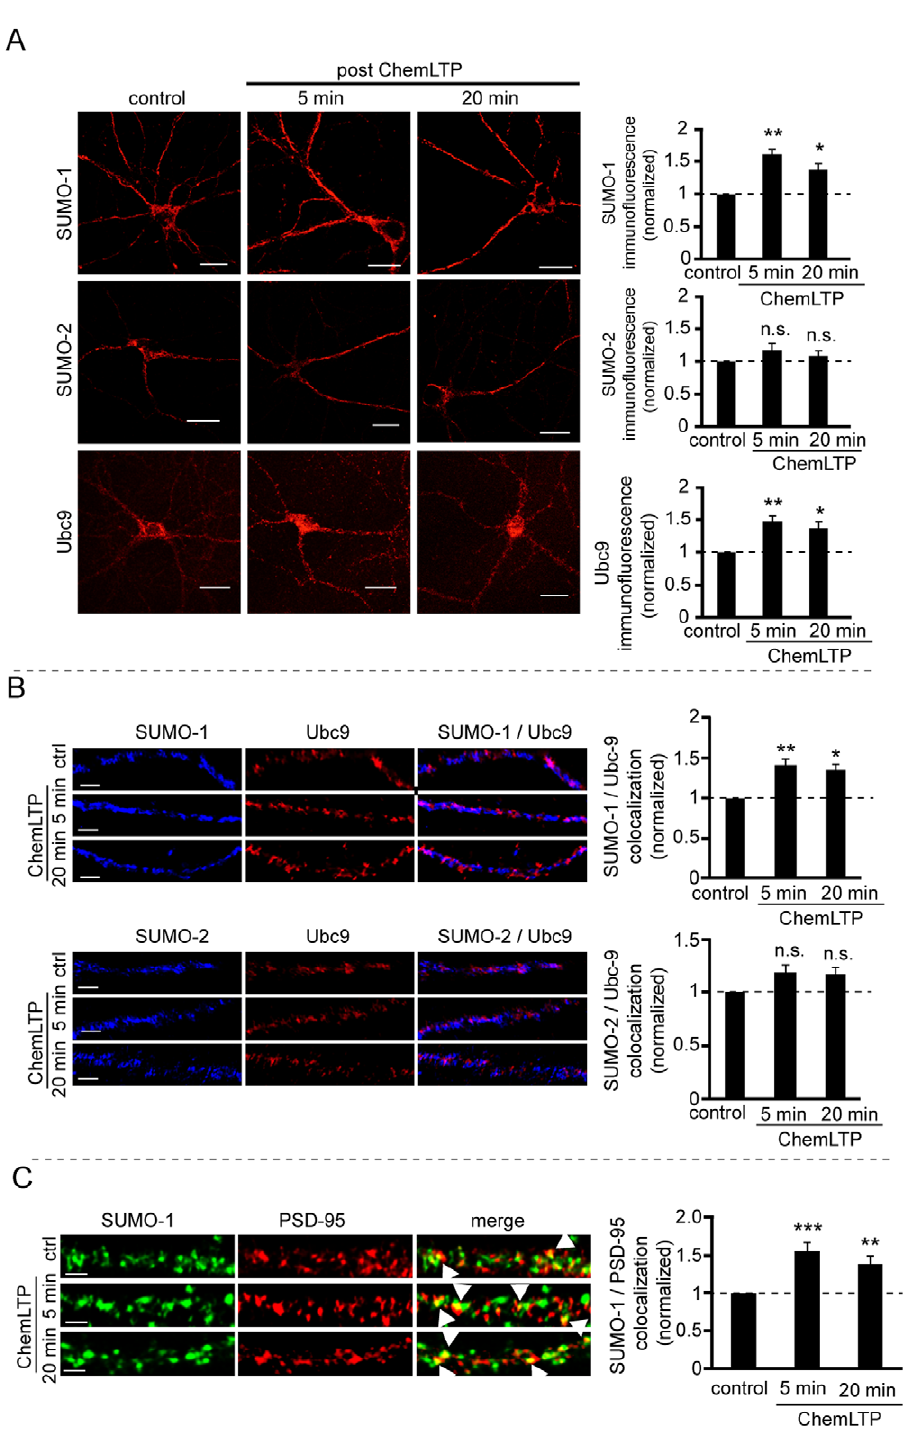
Figure 2. ChemLTP upregulates of SUMO-1 and Ubc9 protein levels. A) ChemLTP increases in SUMO-1 and Ubc9 immunoreactivity with no change in the intensity of SUMO-2 staining. Mean fluorescence intensity was analysed using ImageJ. Graphs show quantification of 3 independent experiments, 10 neurons per condition (ANOVA. *p , 0.02; **p , 0.005). Scale bars – 20 m m. B) ChemLTP enhances colocalization between SUMO-1 and Ubc9, and SUMO-2/3 and Ubc9 in cultured hippocampal neurons. Example of dendritic segments stained for SUMO-1 (upper panel) or SUMO-2 (lower panel) protein (blue) and Ubc9 (red). Colocalized puncta were quantified using JACoP plugin in ImageJ. Analysis was made in at least 3 different ROIs for each neuron (n=10), for each condition in 3 independent experiments. (ANOVA. *p , 0.02; **p , 0.005). C) ChemLTP increases SUMO-1 clusters at synapses. Examples of fluorescence images of dendrites stained for SUMO-1 and PSD95. The colocalized clusters are indicated as yellow puncta. Graph shows quantification of SUMO-1/PSD95 colocalizing pixels. Analysis was performed in at least 3 independent experiments with 10 neurons per condition and 3 ROIs per neuron, using JACoP plugin in ImageJ. Statistical significance was determined using ANOVA. *p , 0.02; **p , 0.005.